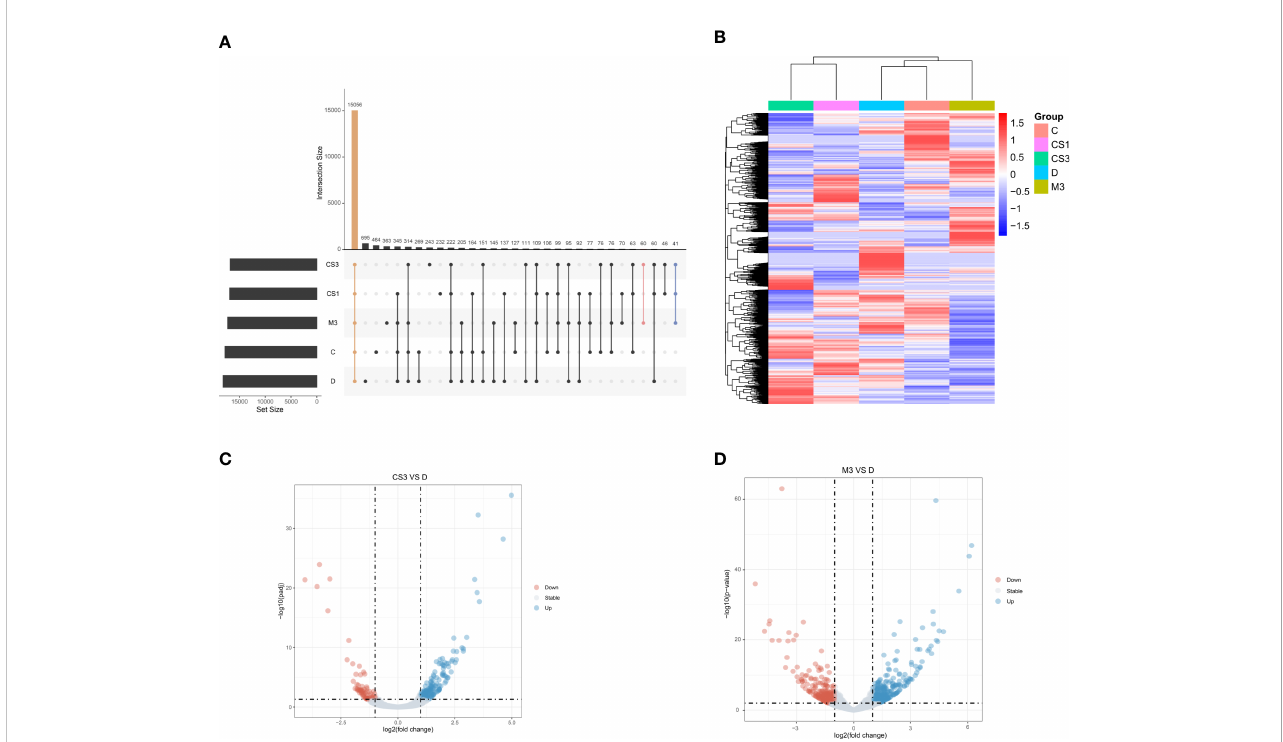
FIGURE 6 Hepatic gene expression of the different groups assessed by RNA sequencing (n=3 for each group). (A) The UpSet plot shows the distribution of DEGs in the fi ve groups. The vertical histogram represents the total number of genes in different events, and the left bar plot represents the size of the gene set in the fi ve groups. The dots represent different groups, and the dotted line shows the groups involved in the event. Orange indicates the largest number of the same genes in all fi ve groups. Pink indicates the largest number of the same genes in the CS3 and M3 groups. Blue indicates the group with the largest number of the same genes included in the CS1, CS3, and M3 groups; (B) Heatmap of DEGs between groups; (C) Volcano plot of DEGs between groups (CS3 vs. D); (D) Volcano plot of DEGs between groups (M3 vs. D). D, DIO control group; CS3, CS271011 3 mg/kg group; M3, MGL-3196 3 mg/kg group; DEGs, differentially expressed